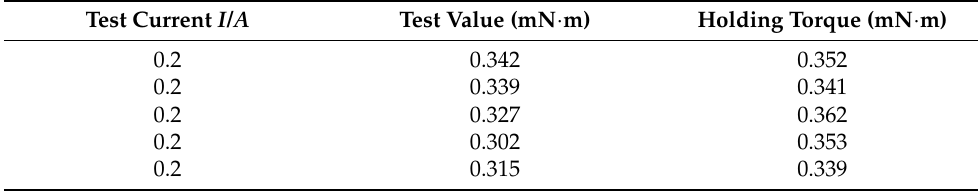
Figure 13. Micro stepper motor torque test bench. Table 3. Stepper motor holding torque test values.